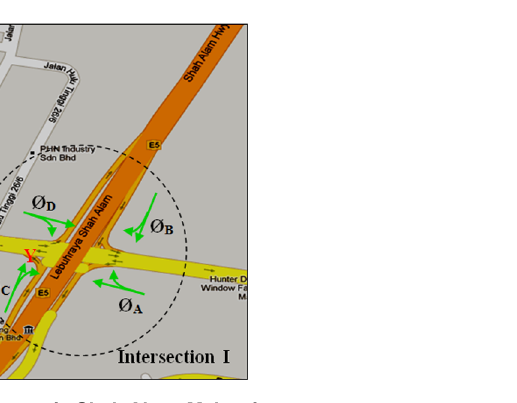
Fig 6. Real-world fixed-time traffic systems in Shah Alam, Malaysia.